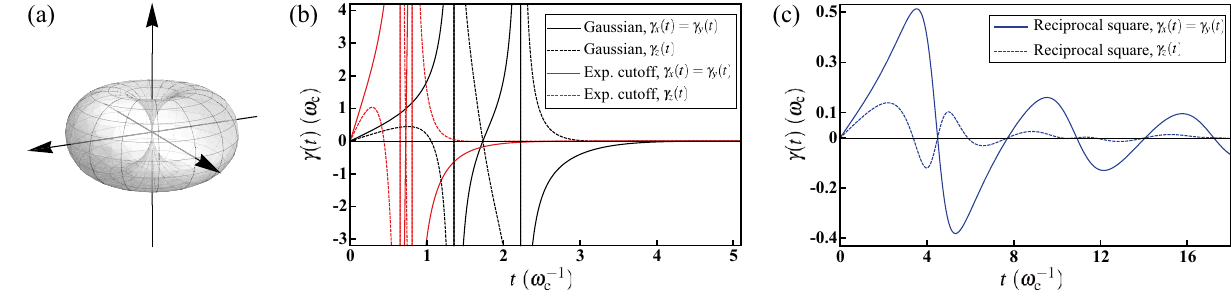
> 1 / 3 > n 2 n 2 n 2 z � � . ( b ) y � � x � � = � � �